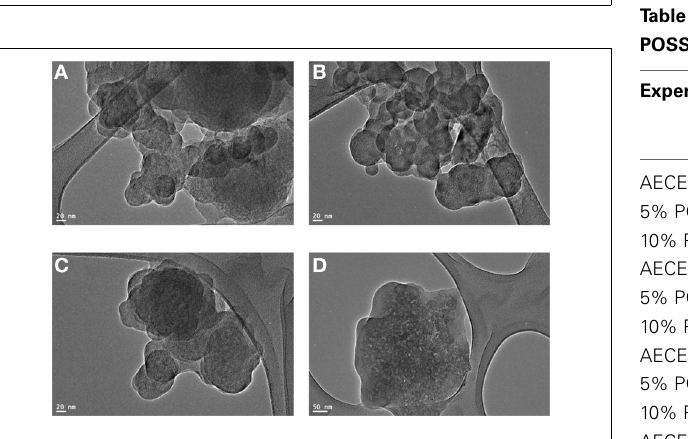
Figure 6 | TEM image of (A). 10% POSS-AECE 1 , (B) . 10% POSS-AECE 2 , (C) . 10% POSS-AECE 3 and (D) . 10% POSS-AECE 4 .